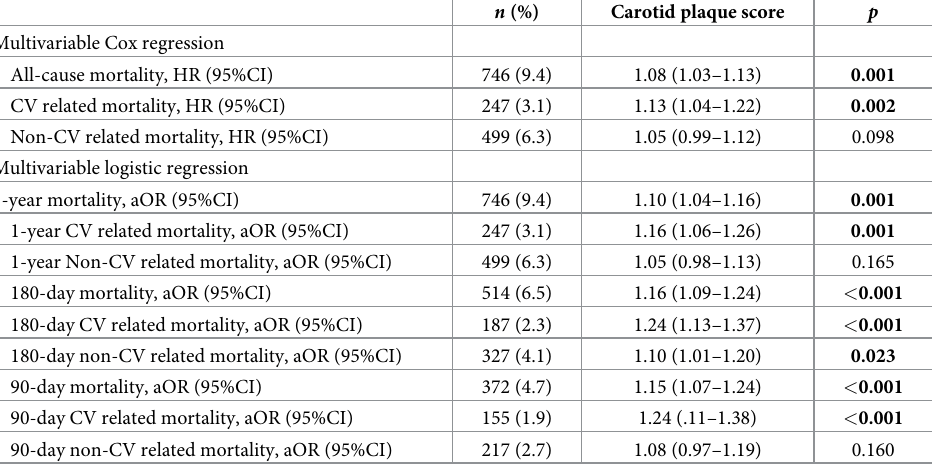
Table 3. Association of carotid plaque score and mortality a .